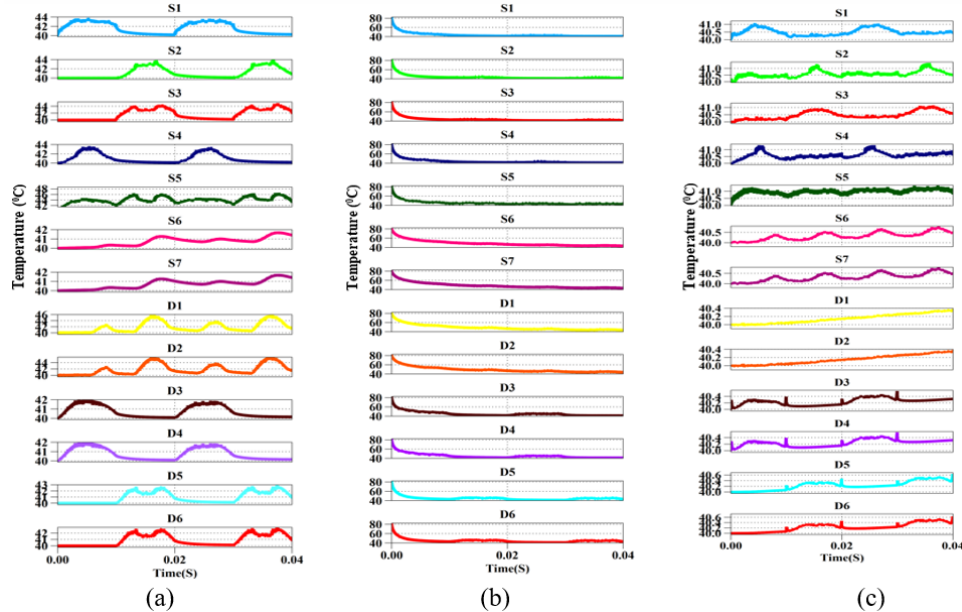
Fig. 11. Junction temperature of components– (a) Si-made (b) SiC-made (c)